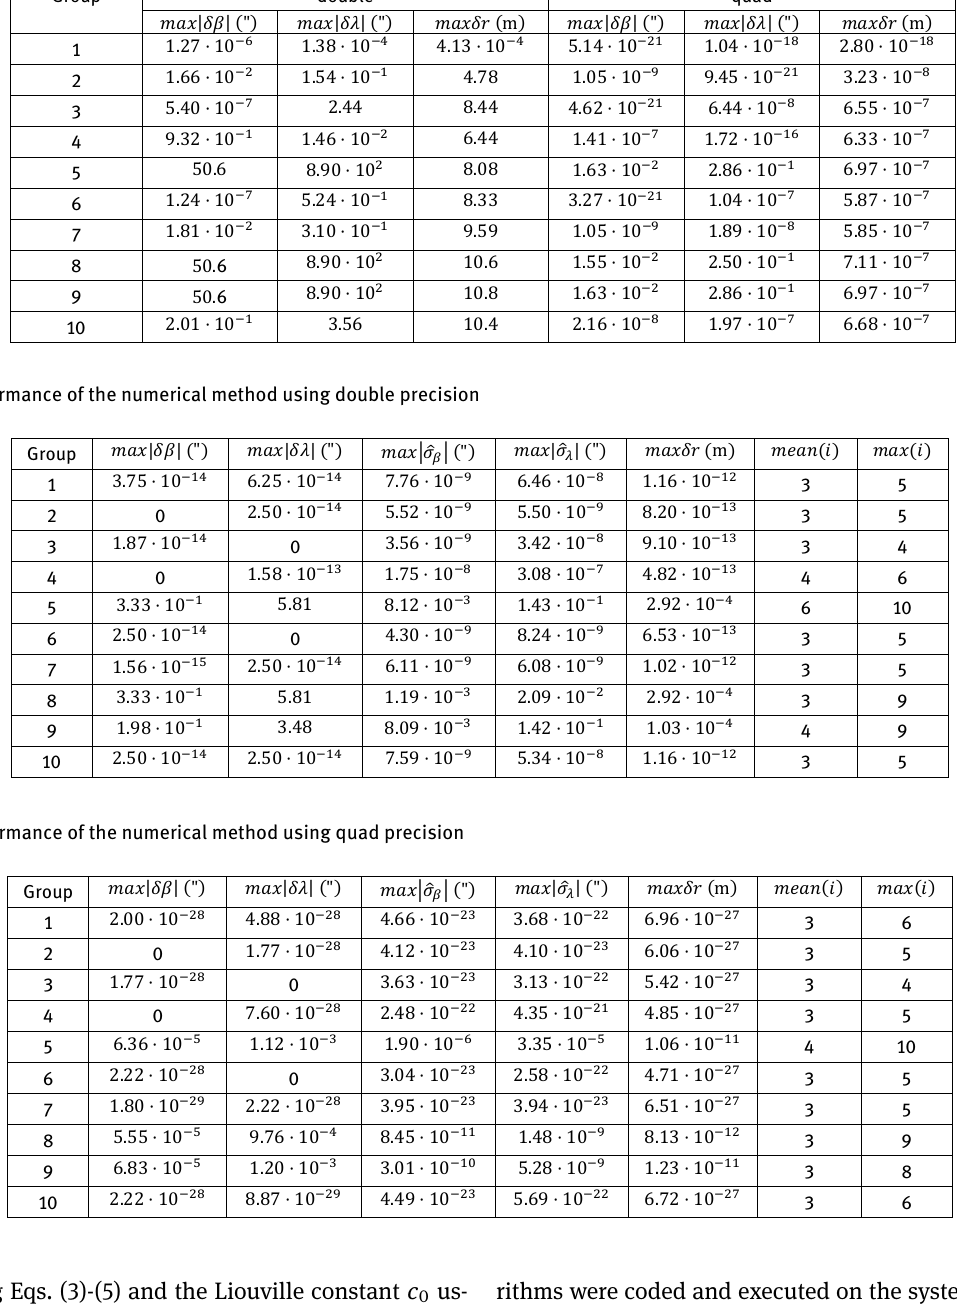
Table 2: Performance of the exact analytical method using double and quad precision Group